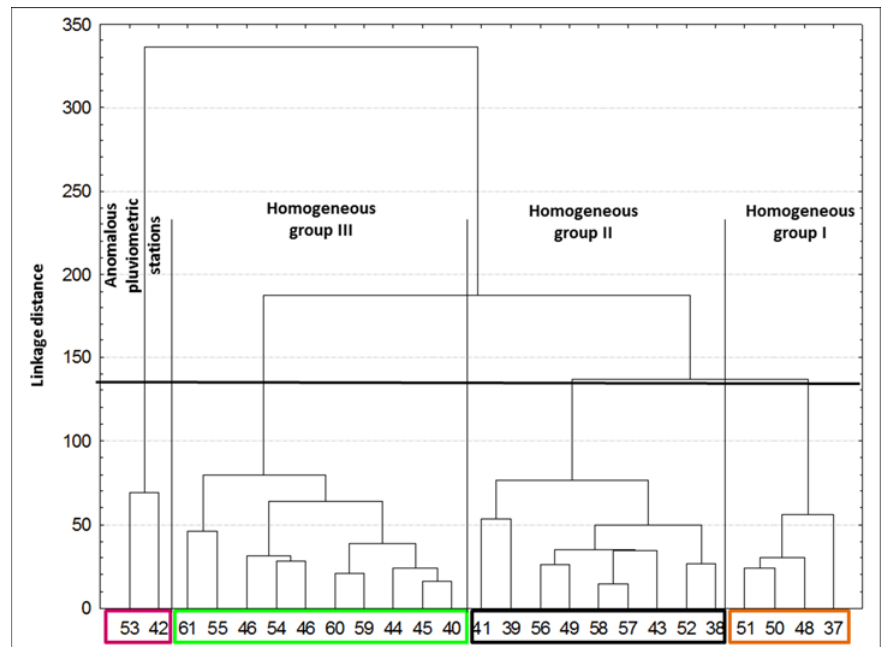
Figure 5. Dendogram with pluviometric stations and meteorological stations and their homogeneous pluviometric groups for the Ribeira watershed.